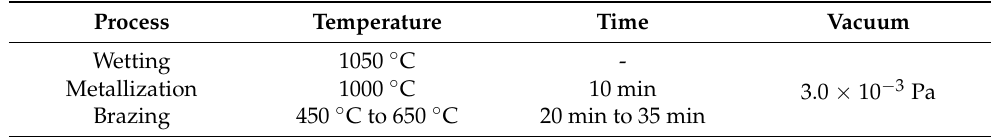
Table 1. Experimental